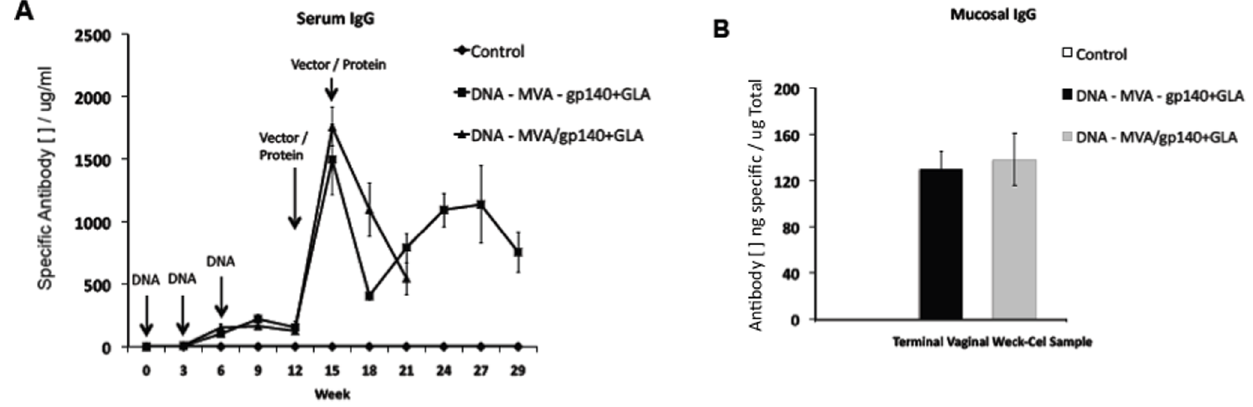
Figure 6. Vaccine elicited CN54gp140-specific serum and mucosal IgG responses in rabbits. Male and female NZW rabbits were primed with three DNA inoculations (8 mg total; 4 mg each leg) into their quadricep muscles then boosted with either MVA – gp140 + GLA given sequentially or MVA/gp140 + GLA administered concurrently in separate leg muscles (MVA-C at 1.3 6 10 8 PFU in 500 m l; CN54gp140 at 100 m g in 400 m l; GLA-AF at 5 m g in 400 m l – co-formulated with CN54gp140 recombinant protein). The antigen-specific serum IgG response over the course of the vaccine regimen ( A ) and the mucosal IgG response at termination ( B ). Antigen-specific rabbit IgG antibody was assessed by an immunoglobulin ELISA with a rabbit purified IgG standard curve. Antigen-specific IgG concentrations are shown in m g/ml ( + / 2 SEM).